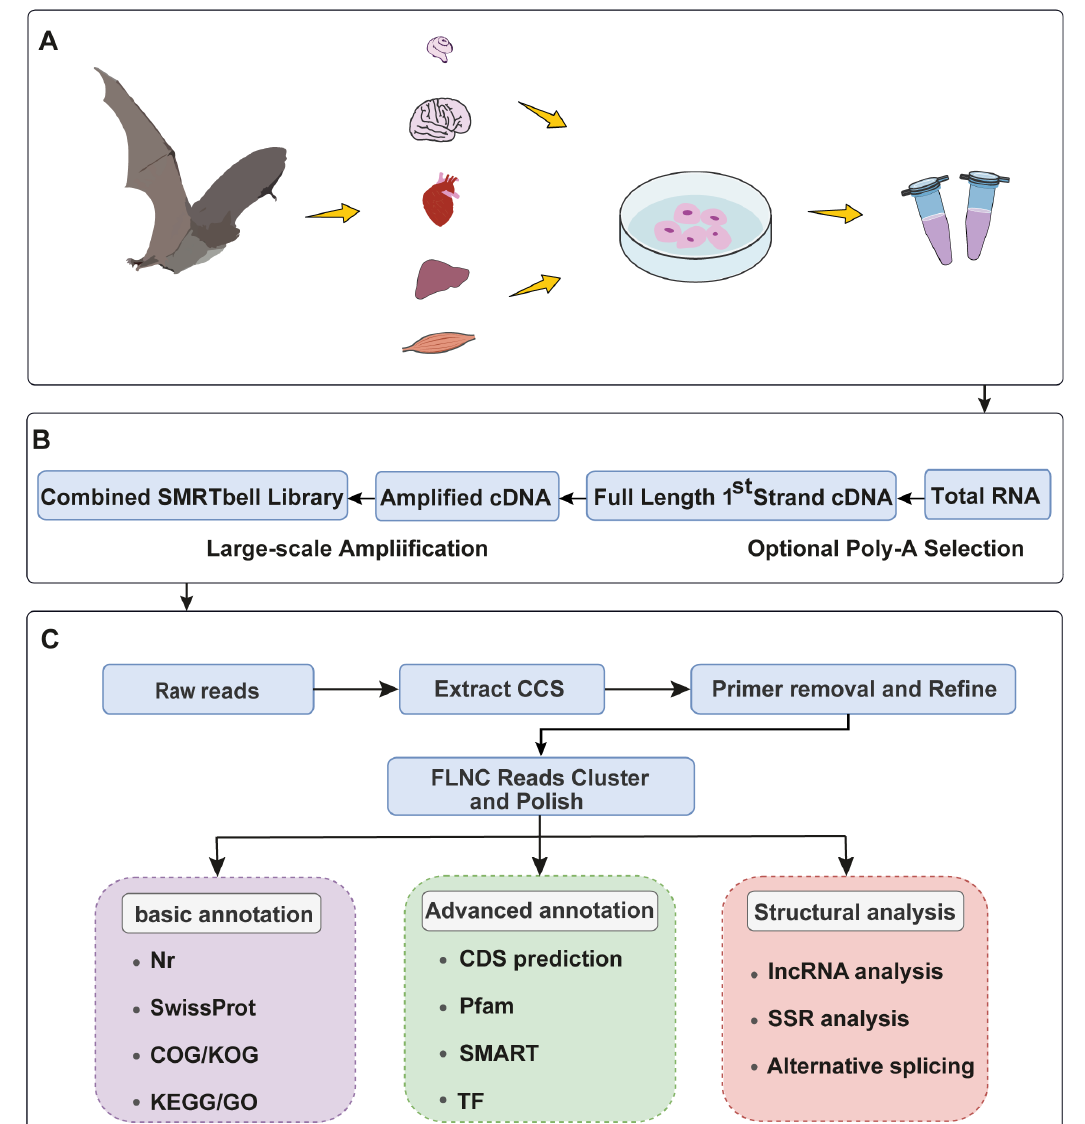
Figure 1. Schematic of the full-length transcriptome reconstruction and analysis pipeline. ( A ) Multiple tissues were extracted from M. pilosus and sequenced. ( B ) The workflow of library construction. ( C ) Bioinformatic analysis pipeline.